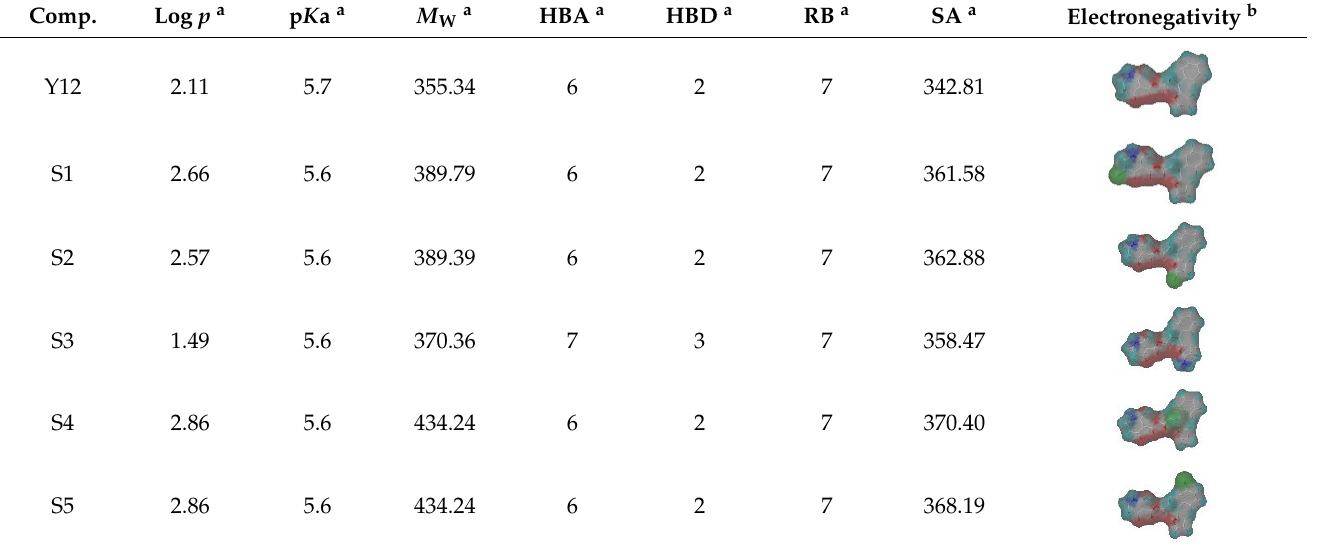
Table 6. Screening result for 5 Table 6. Screening result for 5 compounds. Table 6. Screening result for 5 compounds. Table 6. Screening result for 5 compounds. Table 6. Screening result for 5 compounds. Table 6. Screening result for 5 compounds. Table 6. Screening result for 5 compounds.